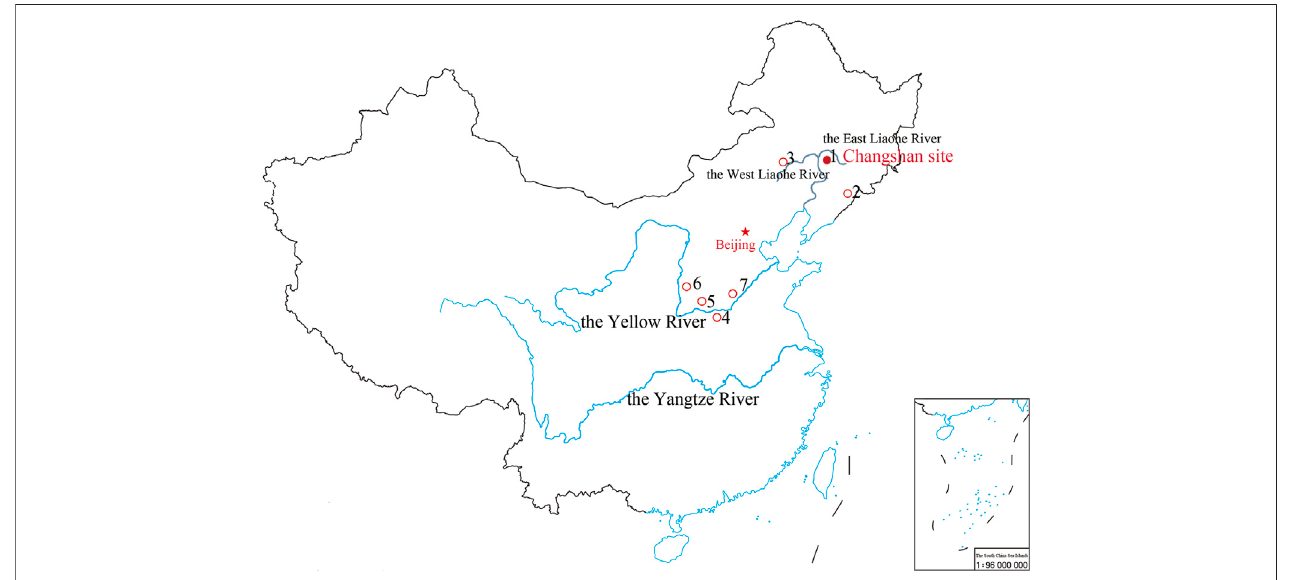
FIGURE 1 | Map of mainland China showing the location of the Changshan site in Jilin Province and the additional archaeological sites mentioned in the text (Original Image Source: http://bzdt.ch.mnr.gov.cn) (1. Changshan site, 2. Wanfa bozi site, 3. Xinglonggou site, 4. Xinzhai site, 5. Erlitou site, 6. Taosi site, 7. Zhangdeng